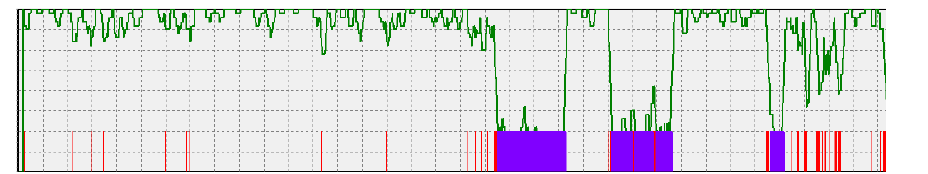
Fig. 2. Significance of indicators related to the work